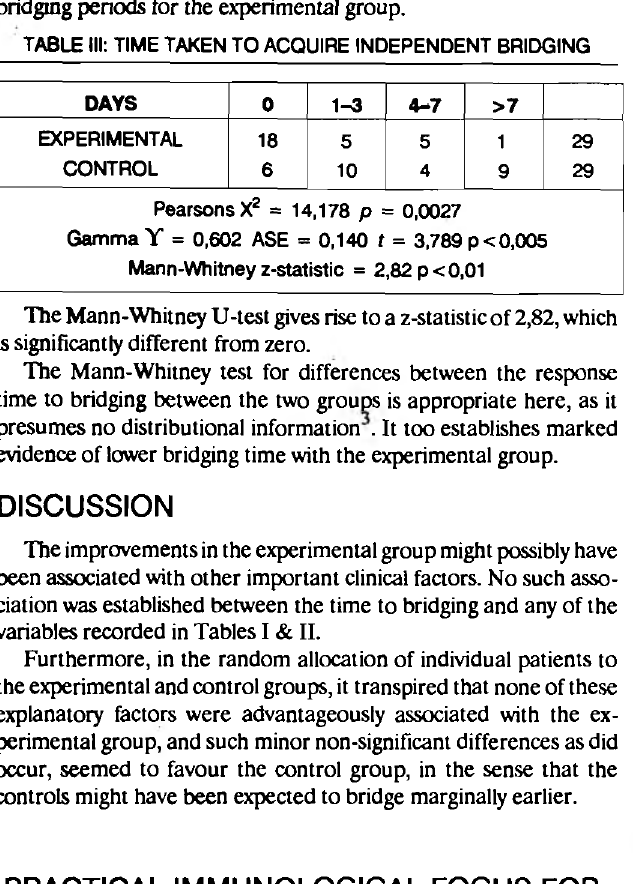
TABLE III: TIME TAKEN TO ACQUIRE INDEPENDENT BRIDGING